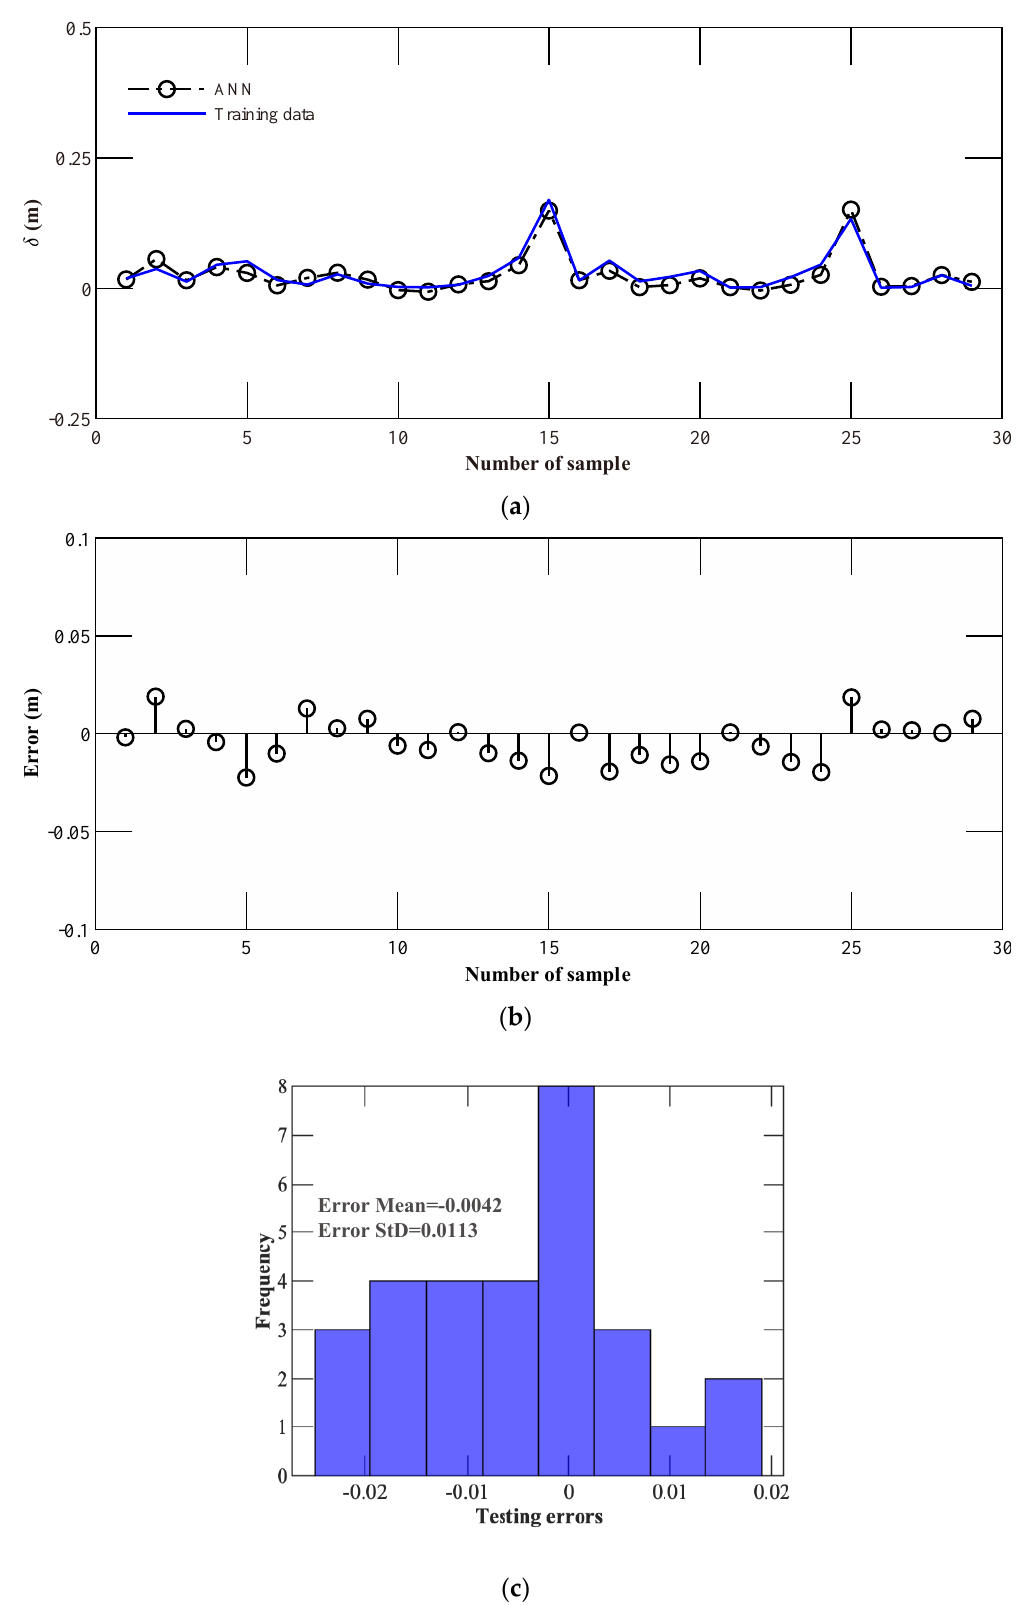
Figure 10. The performance of testing data: ( a ) Predicted versus actual data; ( b ) error; ( c ) the histogram of error values.